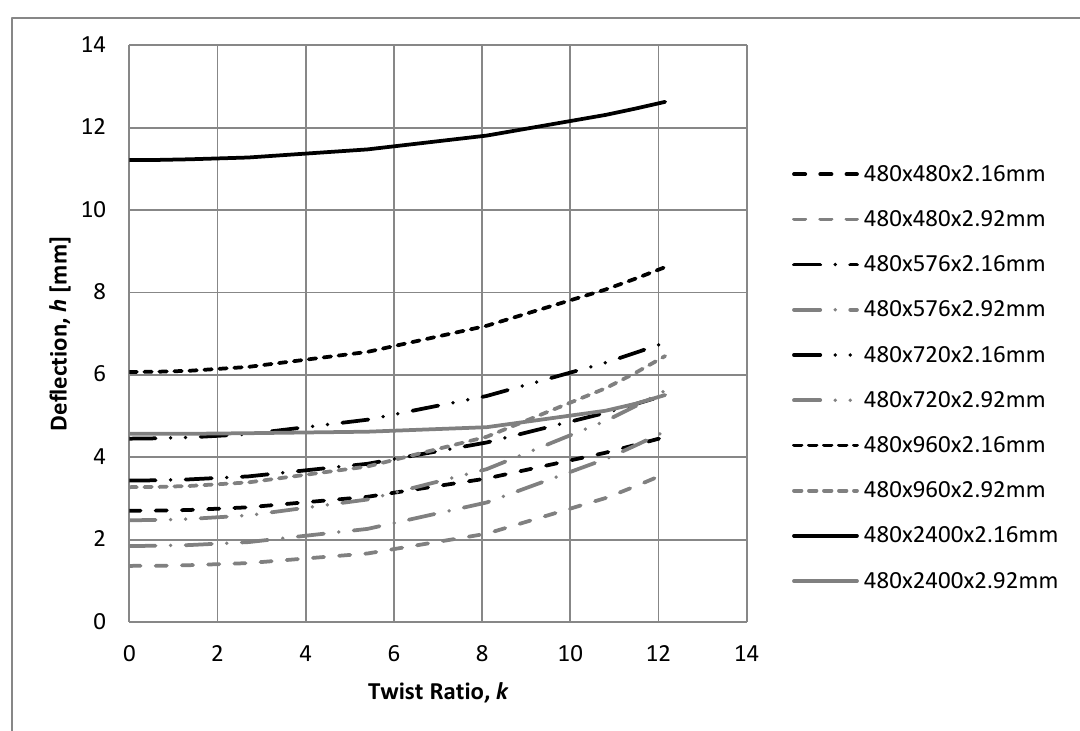
Fig. 5 Transverse deflection of 480mm wide specimens at 1.0